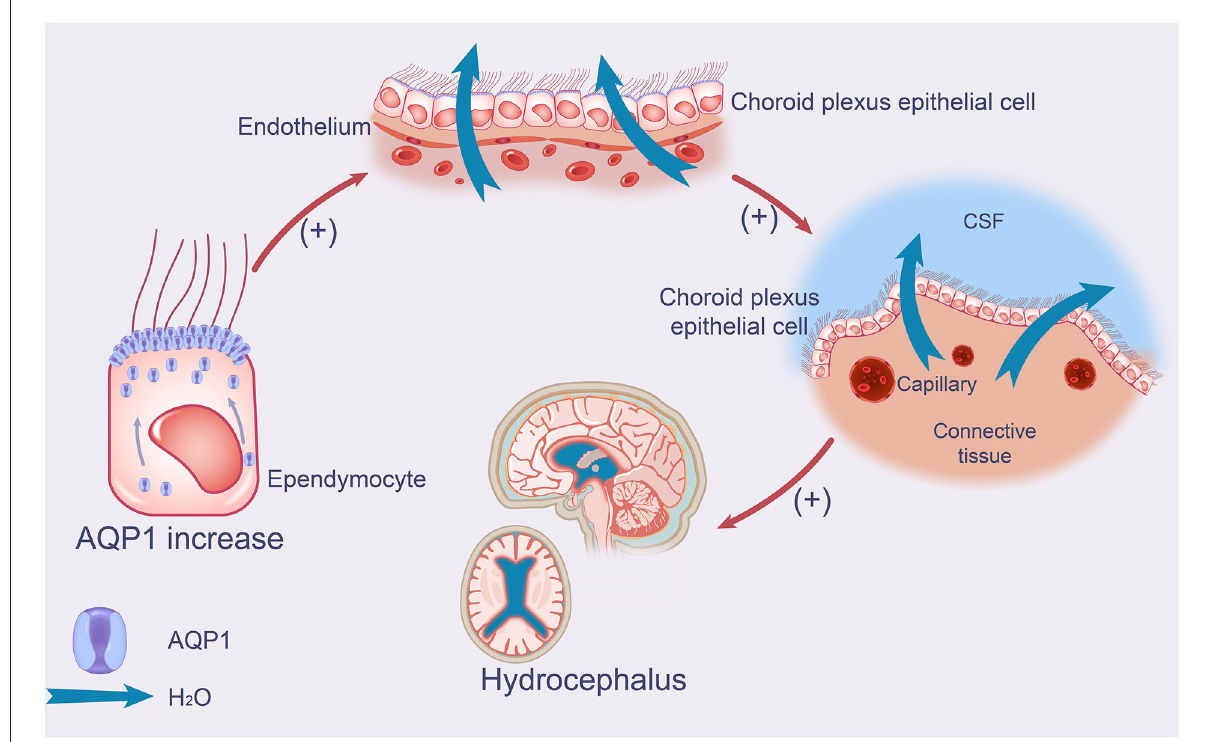
FIGURE1 Effect of AQP1 on production of CSF in iNPH. The schematic drawing demonstrates increases in AQP1 and its function in iNPH, which leads to increased CSF production. AQP1 increases the production and secretion of CSF in the apical membrane of choroid plexus epithelial cells by accumulating in the ependymal membrane of ependymal cells. AQP1, aquaporin 1; iNPH, idiopathic normal pressure hydrocephalus; CSF, cerebrospinal